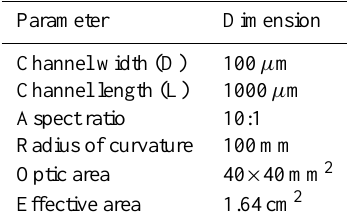
Table 3. MCP optic parameters considered in X-ray studies to date and in the present work.